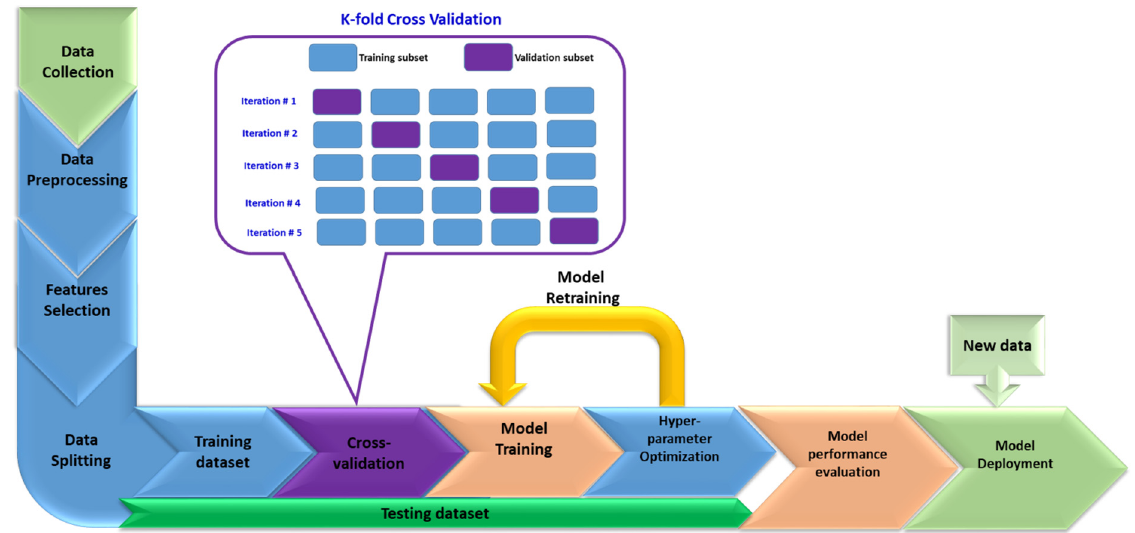
Figure 4. Workflow of ML modeling .